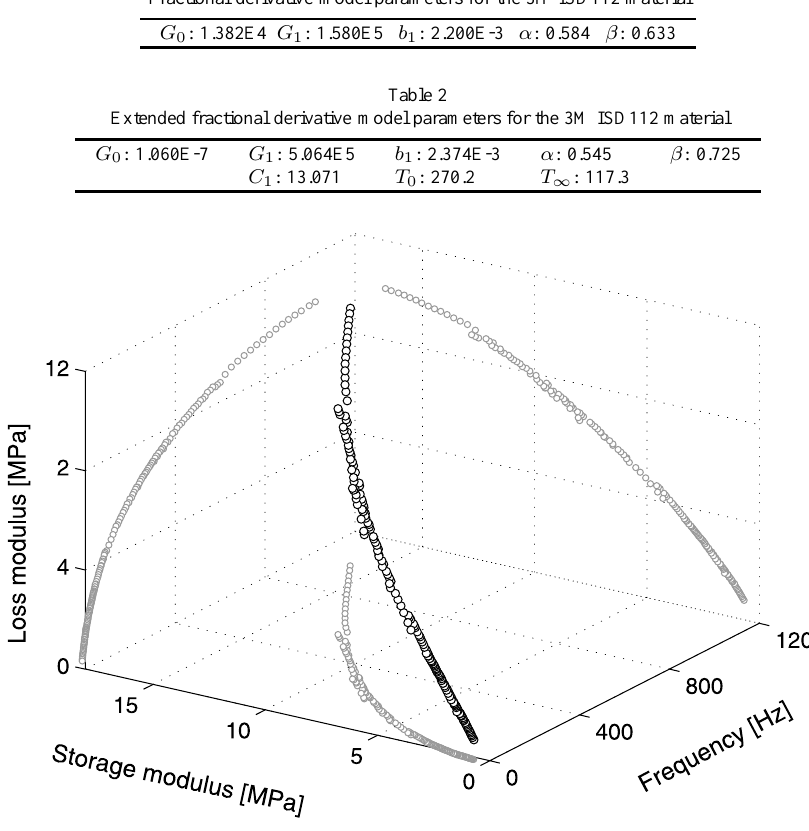
Table 1 Fractional derivative model parameters for the 3M ISD112 material